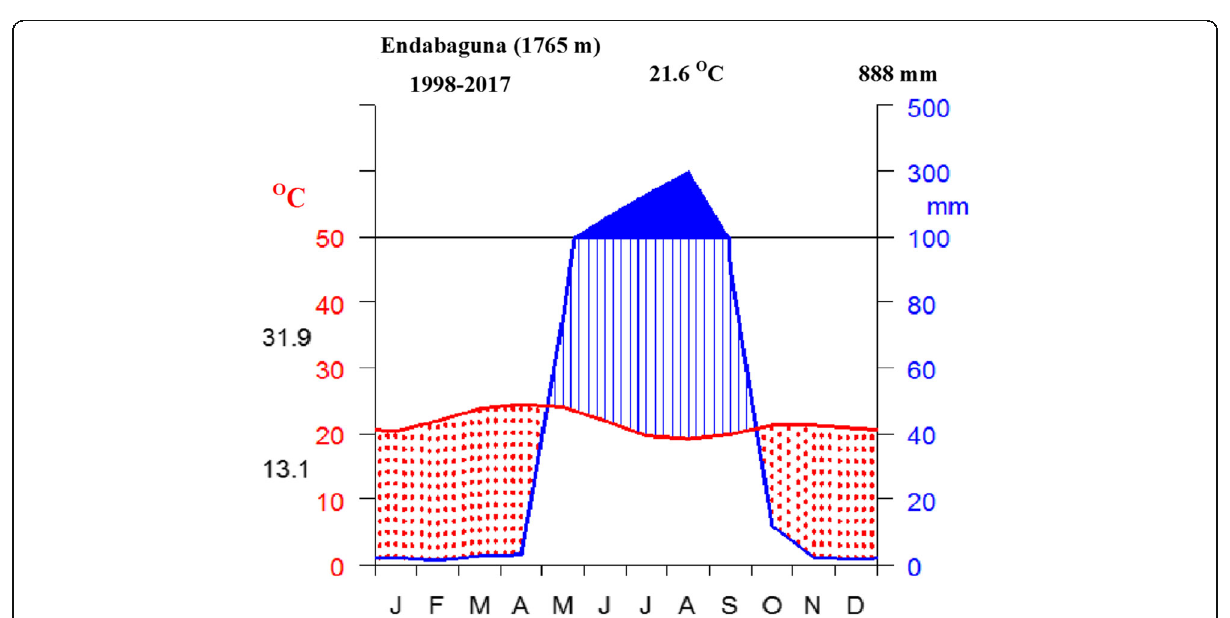
Fig. 2 Climate diagram of the study area (from Endabaguna meteorological